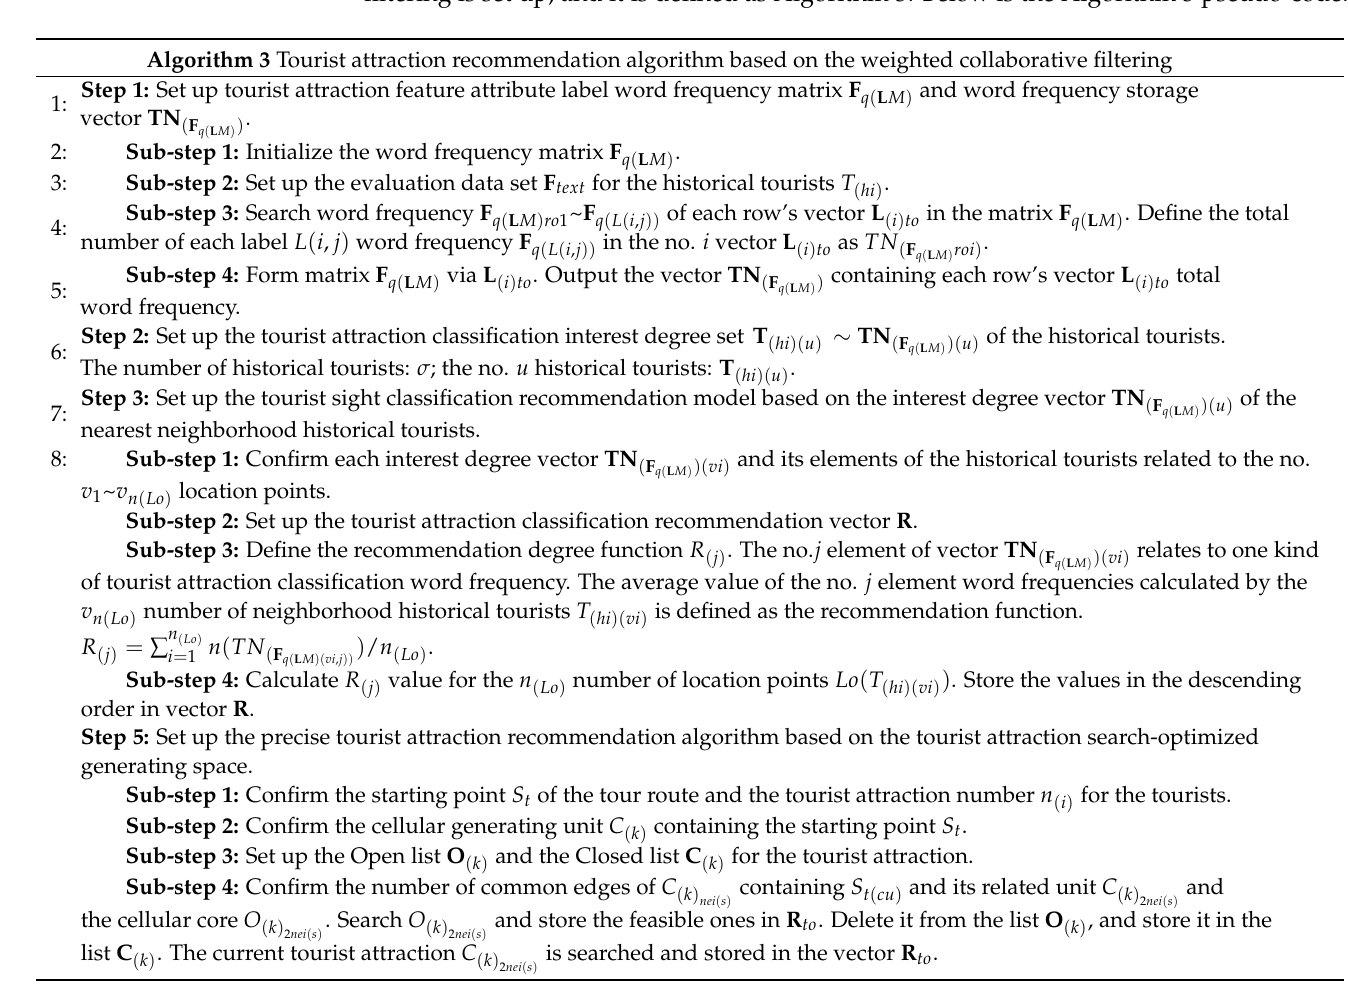
Algorithm 3 Tourist attraction recommendation algorithm based on the weighted collaborative